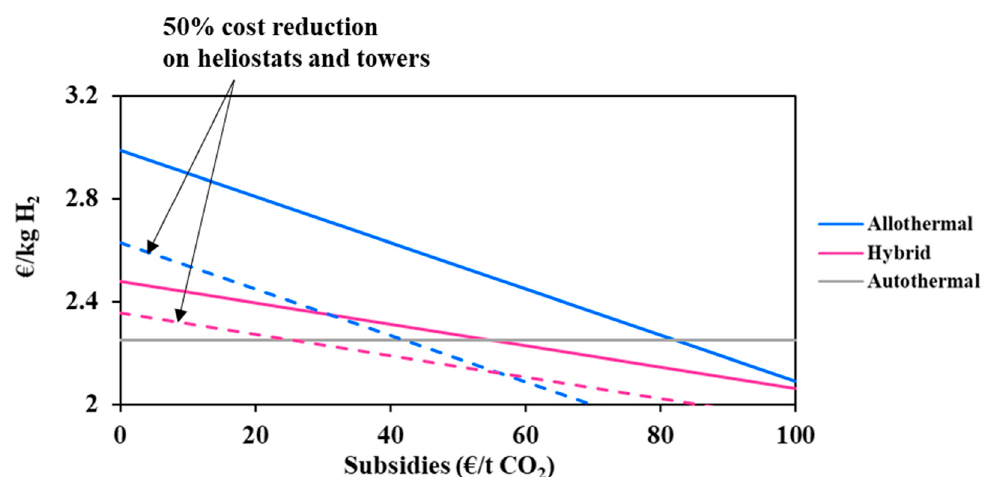
Figure 9. Impact of CO 2 subsidies on hydrogen cost